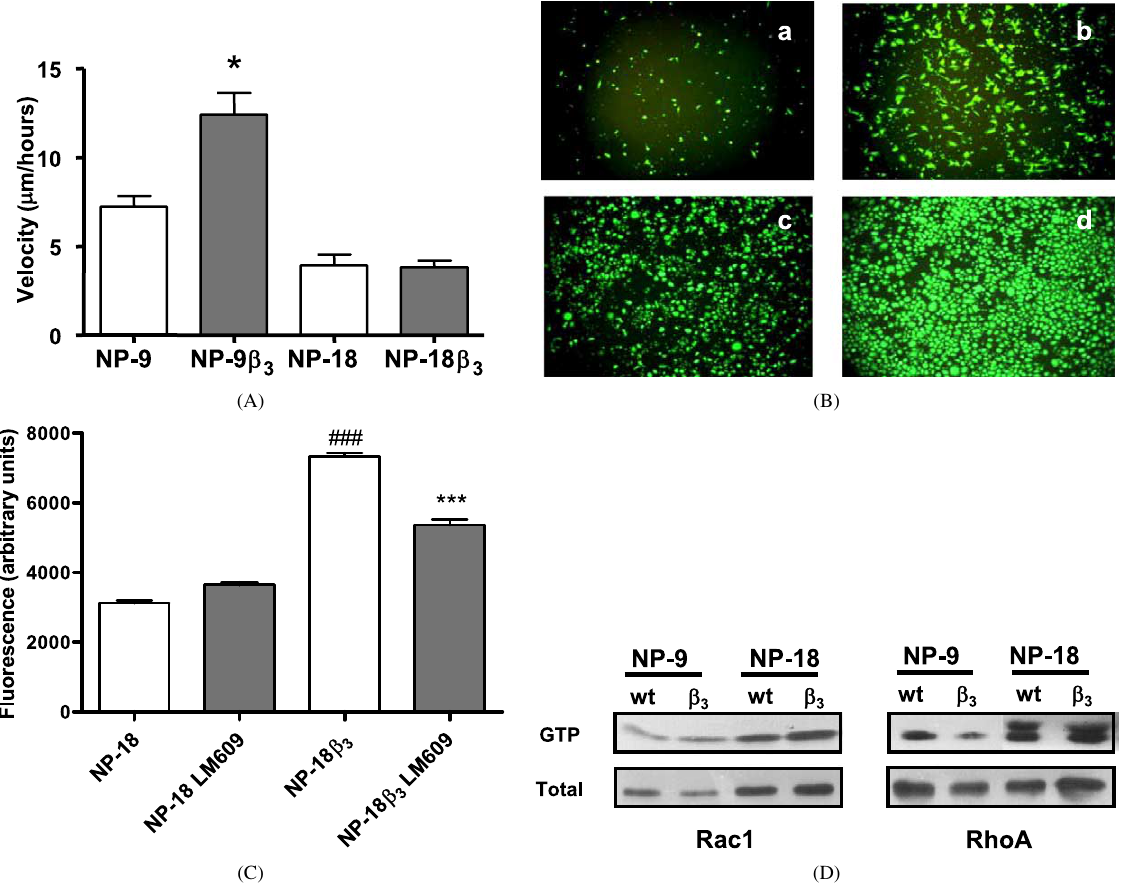
Fig. 4. Migration assays and small G protein activity. (A) Wound healing experiments. Cells were grown under standard conditions to confluence and artificially wounded by disrupting the monolayer with a sterile pipette. Migration velocities were determined using a Widefield CCD System. Bars depict means ± SD migration velocity of two different assays. Statistics: t -test, * p (cid:2) 0 . 05. (B) Transwells assays. Cells were grown on VN-coated transwells and HGF was used as chemoattractant. Microphotographs (10 × ) were taken at 4 h for NP-9 (a) and NP-9 β 3 (b) and at 12 h for NP-18 (c) and NP-18 β 3 (d). A representative assay of three is shown. (C) For migration inhibition assays, purified LM609 mAb was co-incubated during cell migration. Statistics: t -test, *** p (cid:2) 0 . 001 vs. control and ### vs. parental cell line. (D) Rac1 and RhoA activation status. Active cellular RhoA and Rac1 were affinity-precipitated from lysates of cells grown under standard conditions using GST-C21 and PAK-CRIB-coated agarose beads, respectively. Total and active forms were detected by Western blotting using the corresponding antibodies. A representative immunoblot is shown. (Colors are visible in the online version of the article;